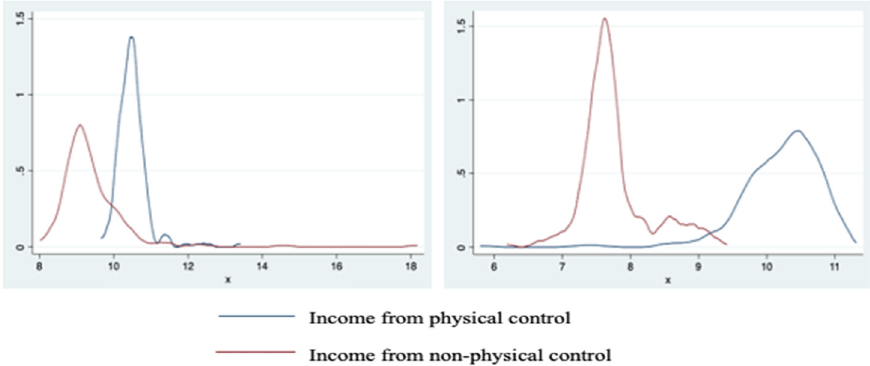
Figure 5. Effects of the choice of rice farmers’ physical control behaviors on the income of rice farmers and rice output.